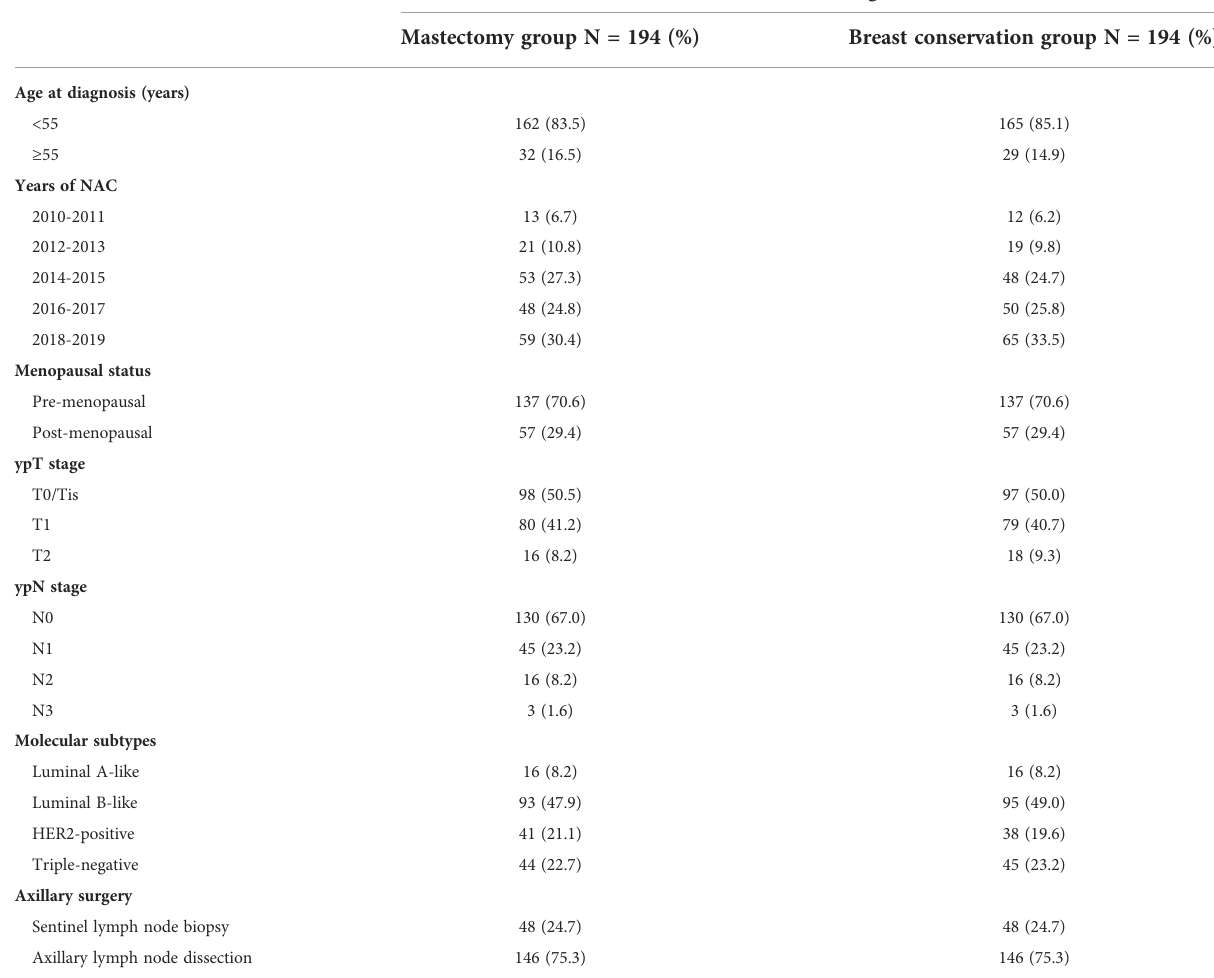
TABLE 3 Balanced statistics of patients receiving neoadjuvant chemotherapy in different surgical groups after propensity score matching.